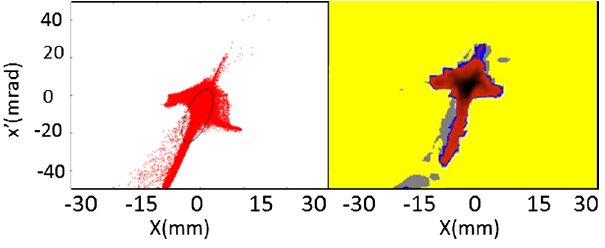
FIG. 15. Phase space simulation (left) and measurement (right) for 1 . 25 × 10 − 6 mbar H 2 .